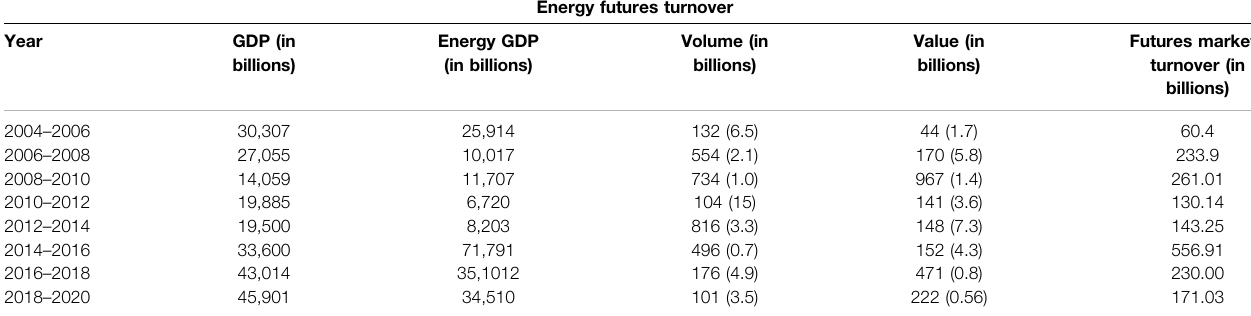
TABLE 2 | Energy prices turnover and energy ef fi ciency with respect to gross domestic